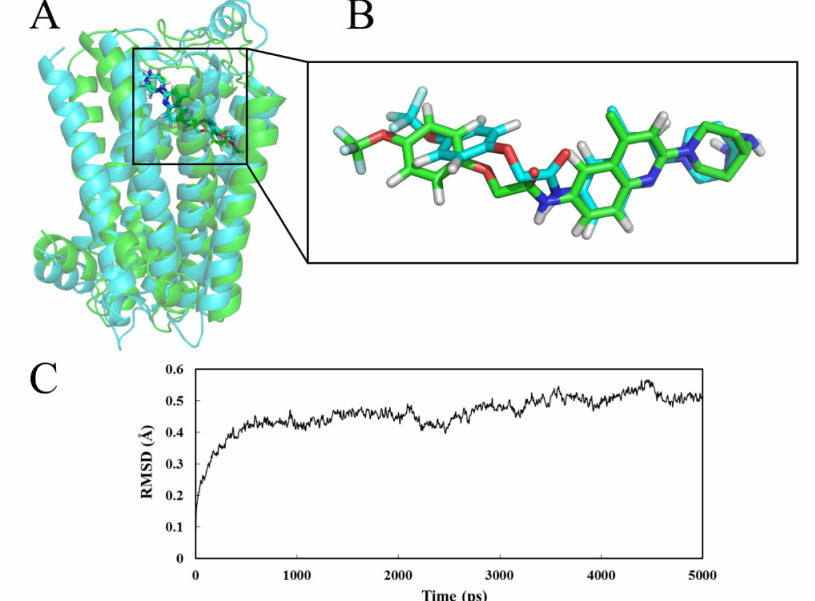
Figure 6. ( A ) View of the superimposed backbone atoms of the average structure for the last 1 ns of the molecular dynamics (MD) simulation (green) and the initial structure (cyan) for the Compound 169 –MCHR1 complex; ( B ) The initial and the final average structures of Compound 169 shown in cyan and green sticks; ( C ) Plot of the root-mean-square deviation (RMSD) of docked complex versus MD simulation time in the MD-simulated